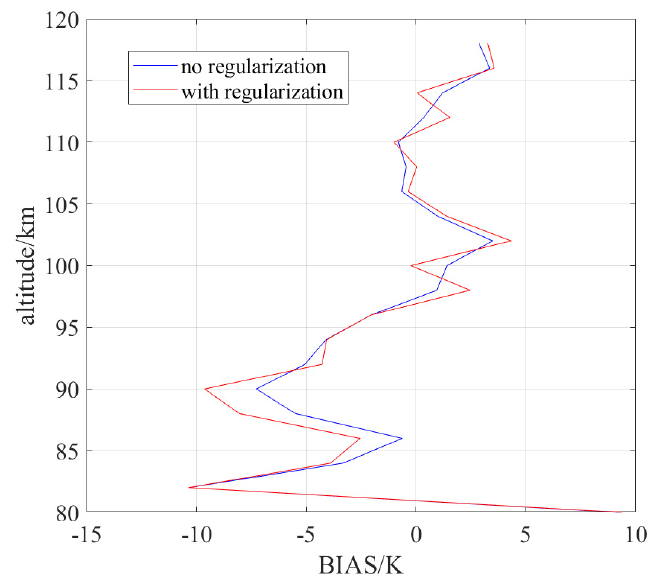
Figure 18. The bias between retrieved temperature and actual temperature combined with regular- ization constraint and without regularization constraint.